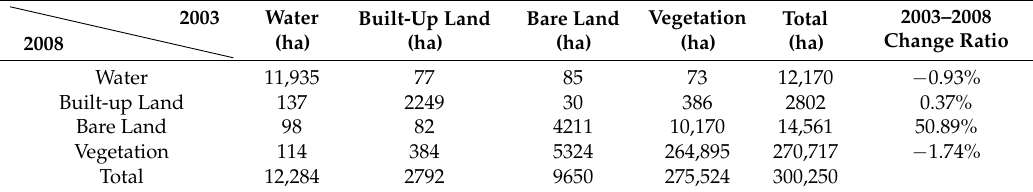
Table 4. Land-cover transfer matrix from 2003 to 2008.